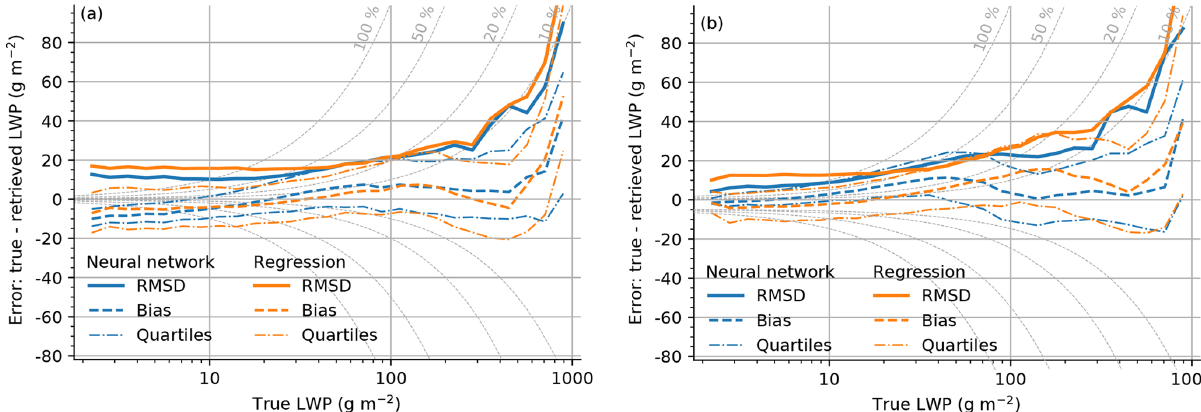
Figure 6. Expected retrieval error as a function of true LWP for neural network and linear regression LWP retrievals. Retrievals (a) trained for 1gm − 2 < LWP < 1000gm − 2 . Retrievals (b) trained including clear-sky cases (LWP < 1000gm − 2 ). Error measures (colored lines) for logarithmically distributed bins with 10 bins per LWP power of 10. Gray dashed lines denote the corresponding relative LWP error.